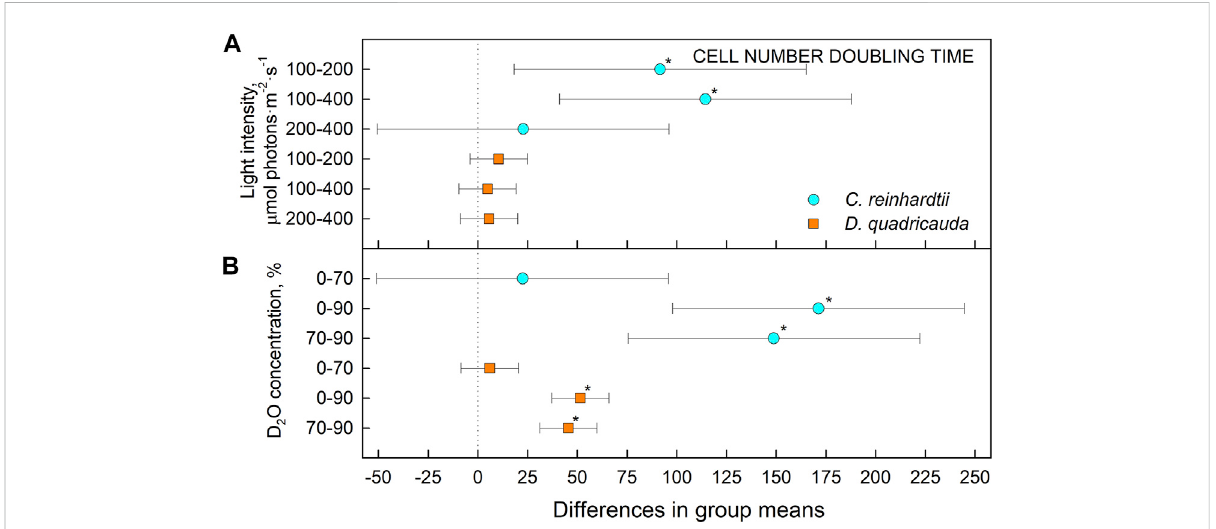
FIGURE 5 Tukey ’ s HSD test of cell number doubling times plotted as 95% con fi dence intervals of mean difference between groups indicated on the left. The effect of light intensity (A) and the effect of D 2 O concentration (B) on mass doubling times of C. reinhardtii (cyan circles) and D. quadricauda (orange squares) are plotted separately. A difference in group means (X axis) equal to zero indicates that the group means are equal, so only a con fi dence interval that does not contain zero is statistically signi fi cant ( p = 0.05, indicated by an